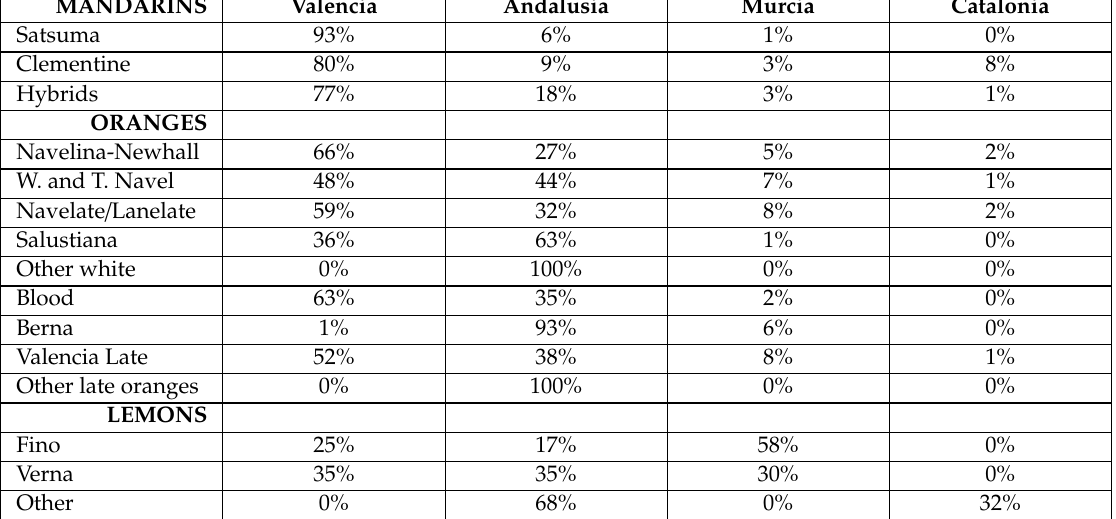
Table 11. Weighting coe ffi cients of producer areas. SOURCE: compiled by the authors on the basis of information from the Regional Ministries and